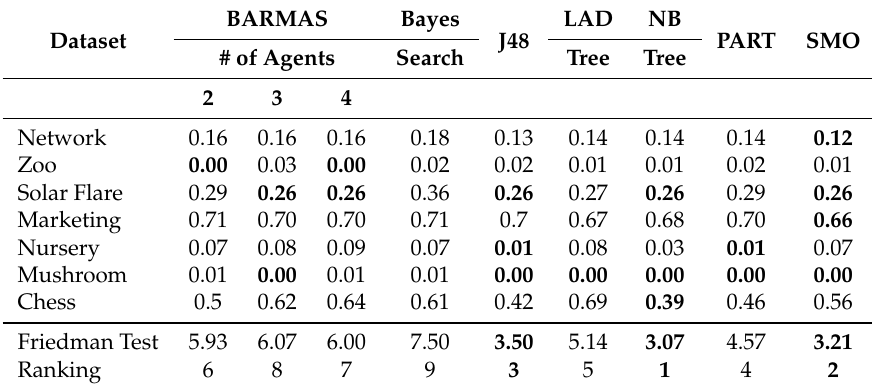
Table 3. Results without uncertainty (all available data). Best results are marked in bold. BARMAS Bayes Dataset